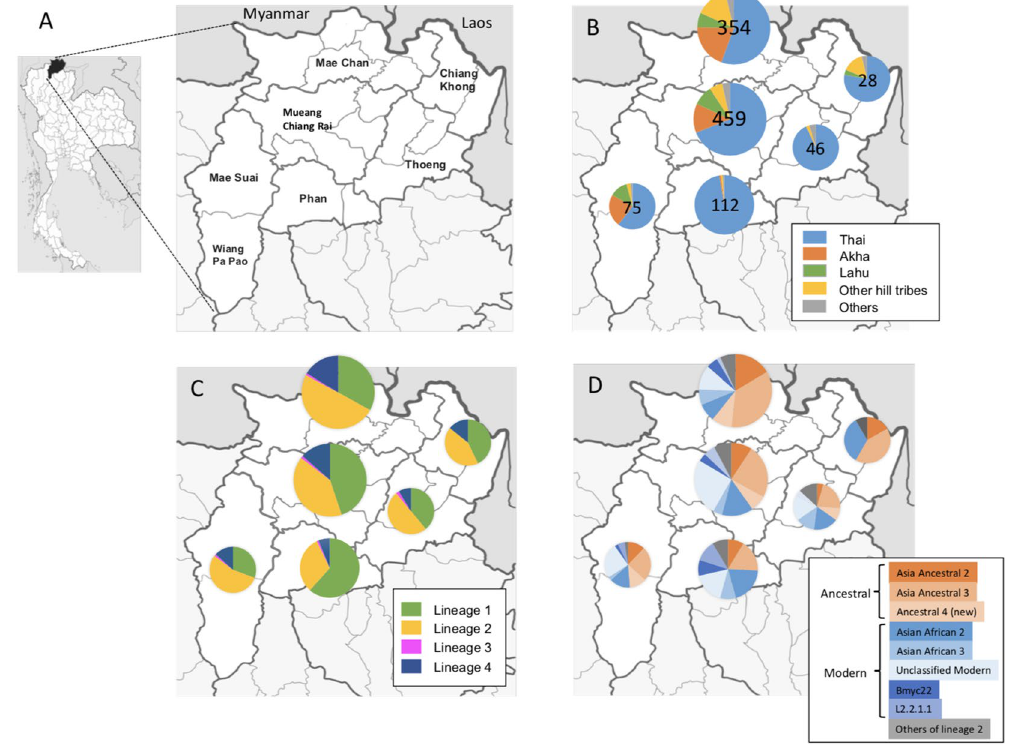
Figure 3. The geographical distribution of patient ethnic groups, various lineages and sublineages of L2 in Chiangrai. 1,098 patients with the geographic information were included. ( A ) Chiangrai is divided into administrative districts. We summarized the data for 6 main areas as shown on the map. ( B ) The distribution of patients in each area by ethnic groups. The number of tuberculosis patients in each area is shown in the pie charts. ( C ) The distribution of the four lineages in each area (N = 1,098). ( D ) The distribution of sublineages of L2 in each area. (N =